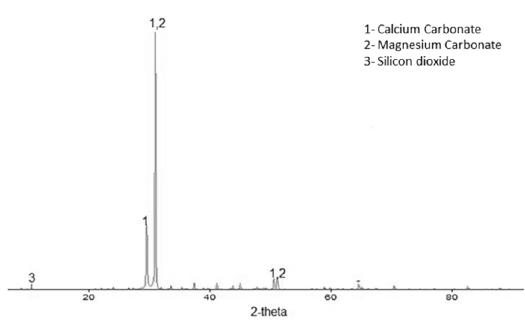
Figure 2. Marble waste X-ray diffractogram.